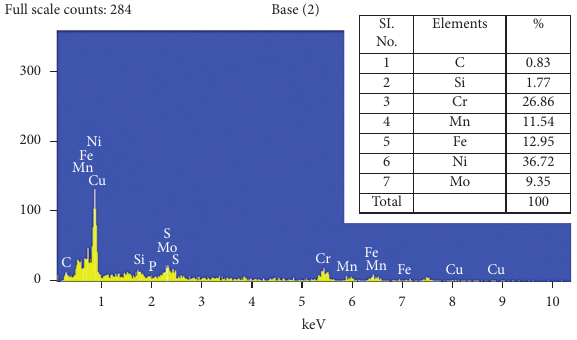
Figure 1: EDS of Altemp HX.